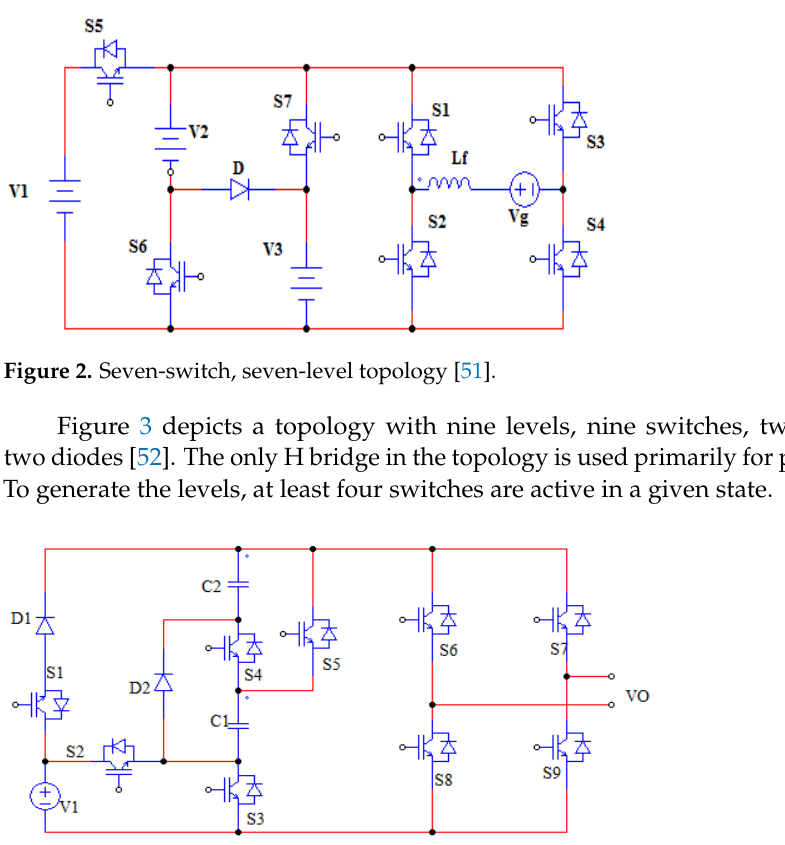
Figure 1. Traditional nine-level cascade inverter [50].